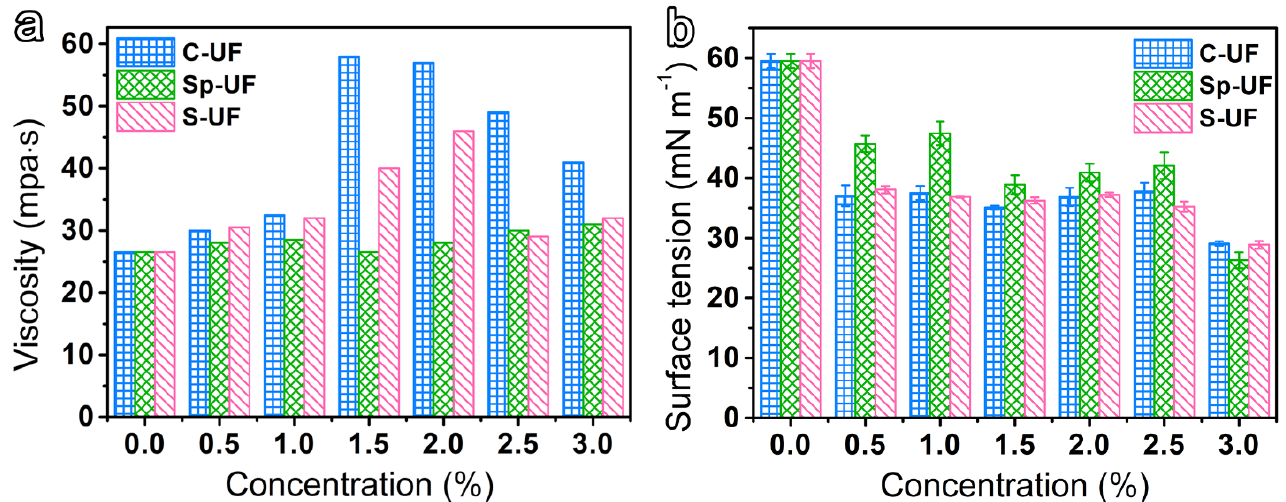
Figure 2. ( a ) Viscosity, and ( b ) surface tension of the UF and reconfigured UF resins. Surface tension is an important factor in evaluating the wettability potential of resin on the substrate [39]. In general, the smaller the surface tension of the solution, the better its wetting performance. Figure 2b shows the surface tension of the different UF